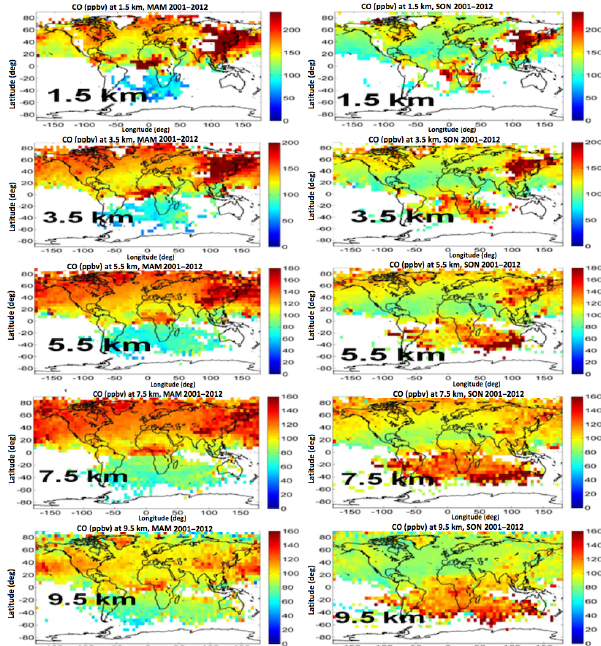
Figure 17. Global distribution of seasonal (the NH spring and fall) mean trajectory-mapped MOZAIC-IAGOS CO climatology as a function of latitude and longitude for altitudes 1.5, 3.5, 5.5, 7.5, and 9.5kma.s.l. The left and right columns show average CO VMRs 2012. The data are averaged with a bin size of 5 ◦ × 5 ◦ latitude and longitude.